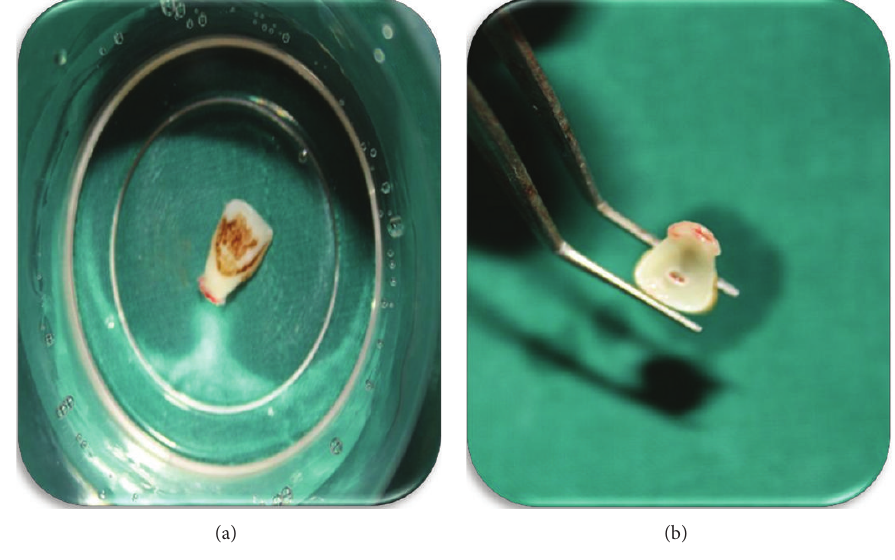
Figure 4: Fracture fragment.